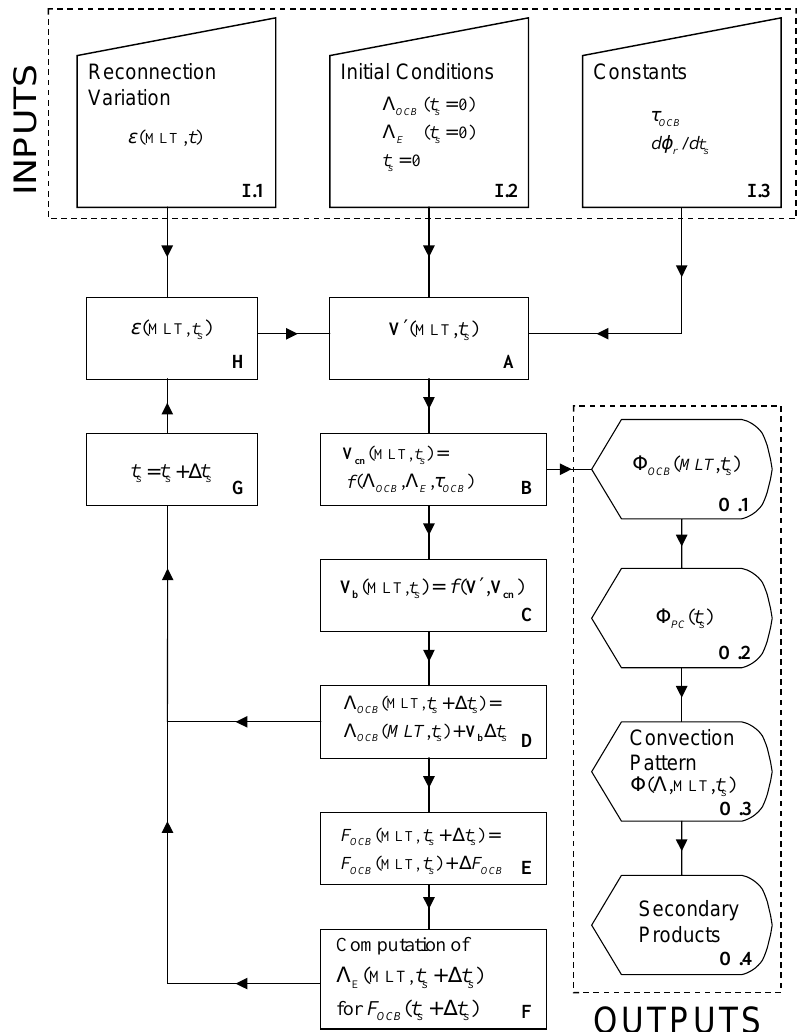
Fig. 1. Flowchart describing the operation of the model presented in Paper 1. Inputs to the model are shown in boxes I.1, I.2 and I.3. Model processes are shown in the boxes labelled A-H. Outputs are shown in boxes 0.1–0.4. (see text for further